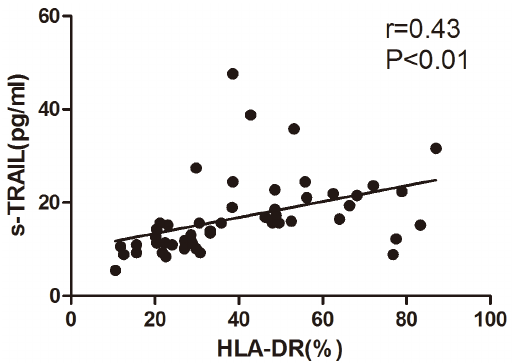
Figure 2. Correlations between plasma TRAIL level and HLA-DR expression on monocytes in septic patients. Pearson correlation analysis, r=0.43, P , 0.01.